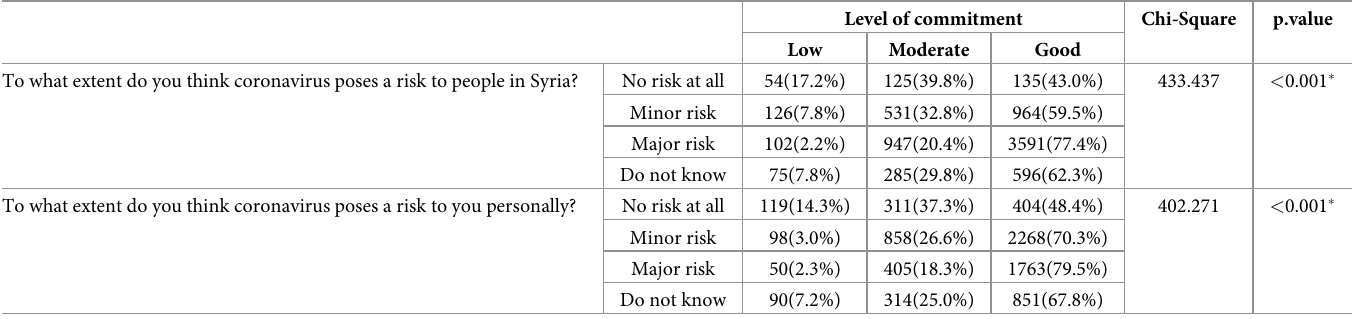
Table 6. Correlation between risk perception and commitment to preventive